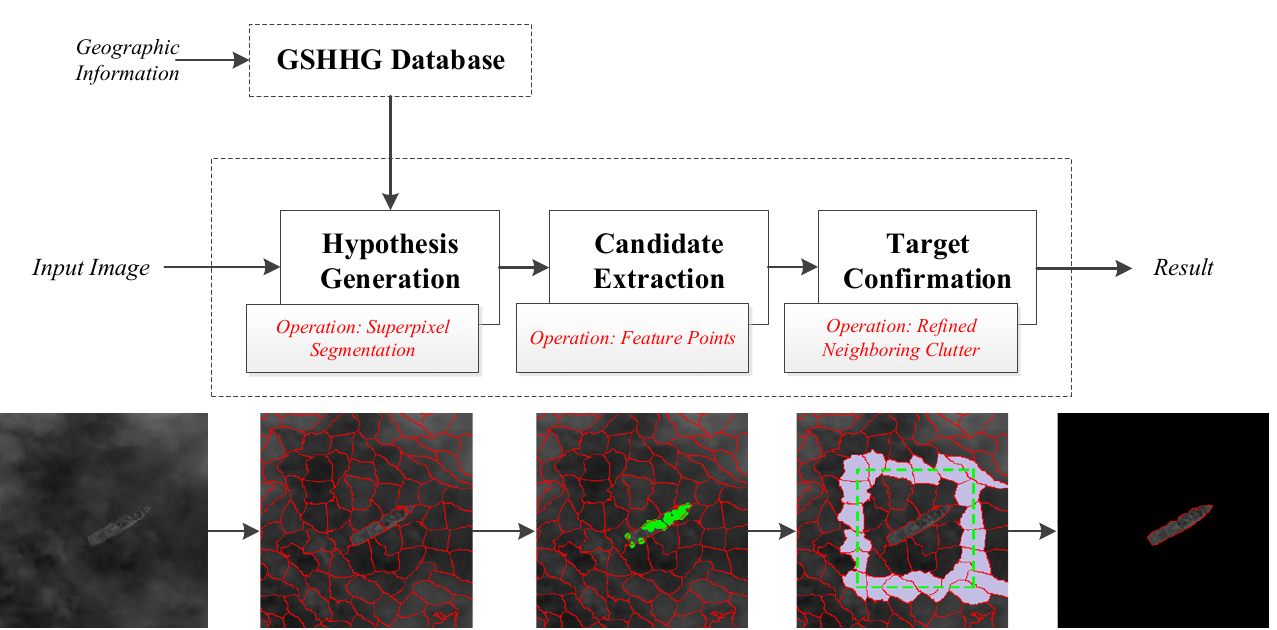
Figure 1. Ship detection procedure of the proposed method. First, we performed image masking with ocean regions as study areas, according to the GSHHG Database. Next, within the mask area, we performed hypothesis generation to perform superpixel segmentation of the image. Then, we performed candidate extraction. By extracting feature points, candidate regions were filtered and superpixels were merged. Finally, we confirmed the target through refined neighboring clutter and obtained the result.